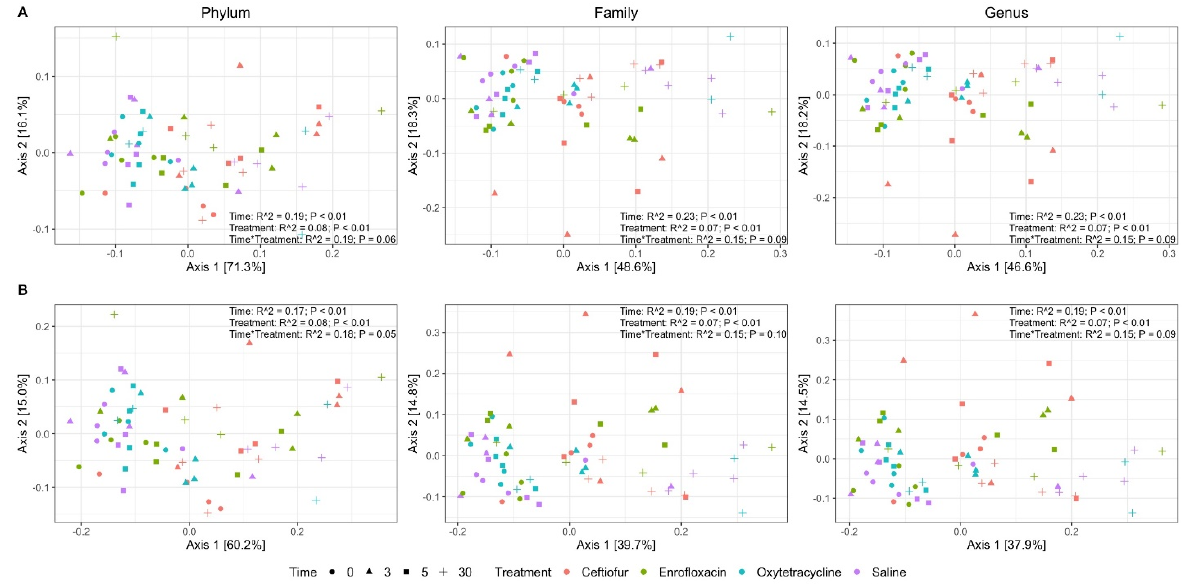
Figure 2. Principal coordinate analysis on Bray-Curtis and Jaccard distances. Distance metrics by panel row are ( A ) Bray-Curtis and ( B ) Jaccard. Samples are colored by treatment and shaped by day. Figure panels in each column are grouped to the displayed taxonomic level. Text within each panel represents the results of PERMANOVA testing against time, treatment and their interactions.